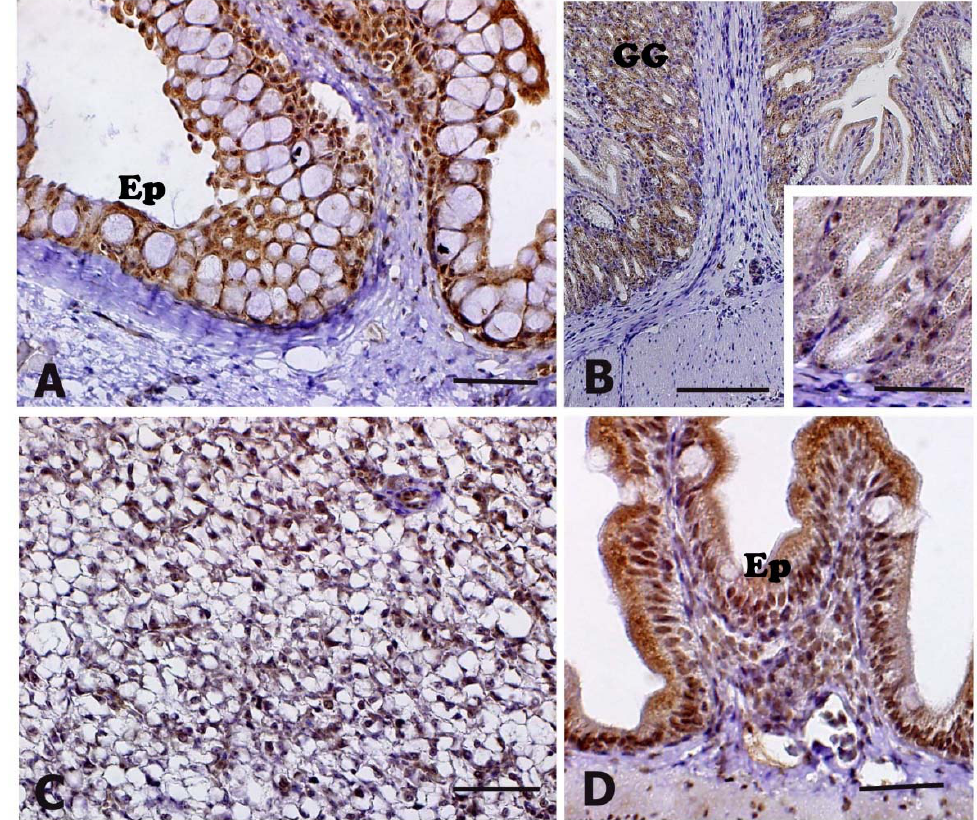
Figure 4. 4 ‐ hydroxy ‐ 2 ‐ nonenal ( HNE) immunohistochemical localization in meagre ( Argyrosomus Figure 4. 4-hydroxy-2-nonenal (HNE) immunohistochemical localization in meagre ( Argyrosomus regius ). Panels ( A) , (B) and ( D) represent animals exposed to transport stress, whereas panel C and regius ). Panels ( A) , ( B ) and ( D ) represent animals exposed to transport stress, whereas panel ( C ) and the insert in ( B) represent a control animal. No differences in term of immunoreactivity